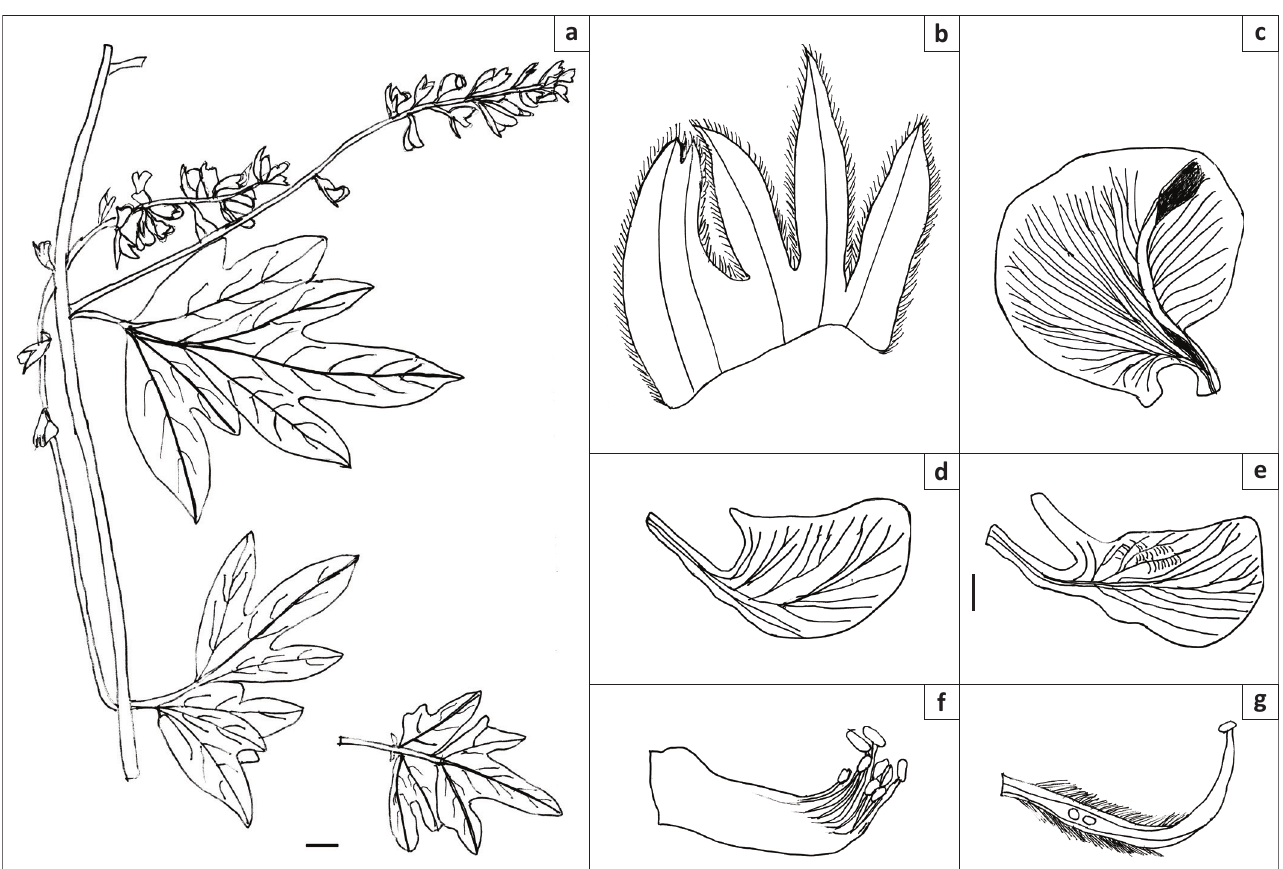
FIGURE 4: Vegetative and floral morphology of N. ficifolius . (a) Flowering branch; (b) calyx opened out with upper lobes to the left; (c) standard petal; (d) keel petal; (e) wing petals; (f) stamens; (g) pistil. Scale bars: (a) 10 mm; (b–g) 2 mm. Vouchers: (a1) R. Story 1479 (PRE); (a2) O. J. Hansen 3030 (PRE); (b–g) Leendertz 83